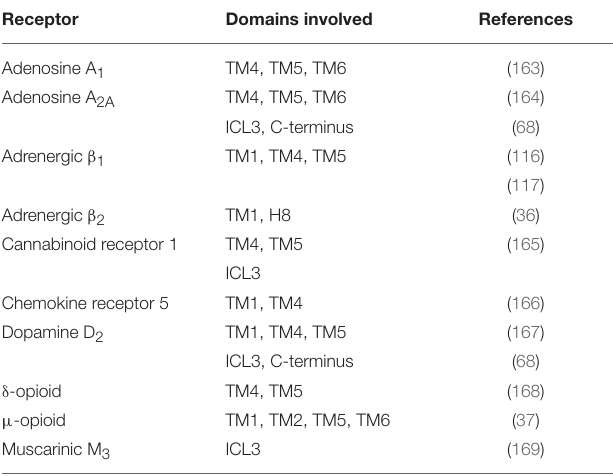
TABLE 2 | Examples of experimentally assessed dimerization interfaces in GPCRs. Receptor Domains